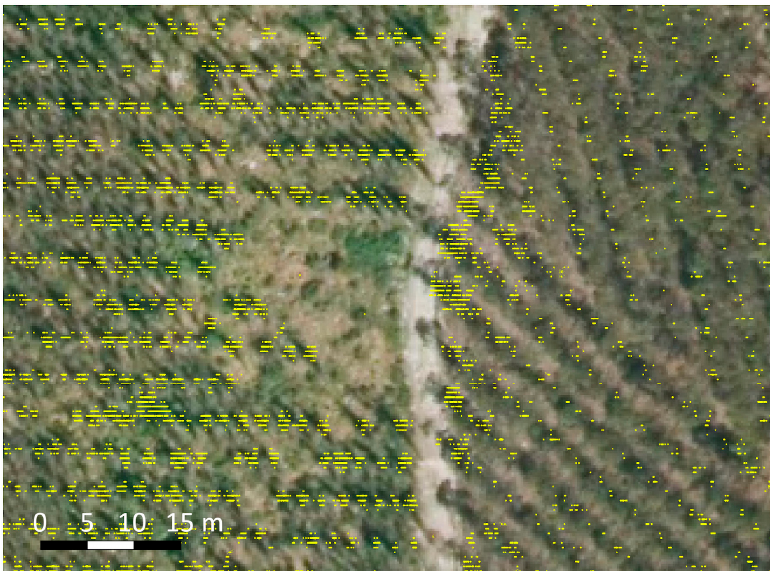
Figure 6. Detail of an aerial image superimposed with the laser returns corresponding to the stem layer (aerial image from Plan Nacional de Ortofotografía Aérea (PNOA) 2016, https://pnoa.ign.es). Method 1 yielded density values closer to the reference value for both plots. An example of the yielded results for a tree line for both methods is shown in Figure 7.